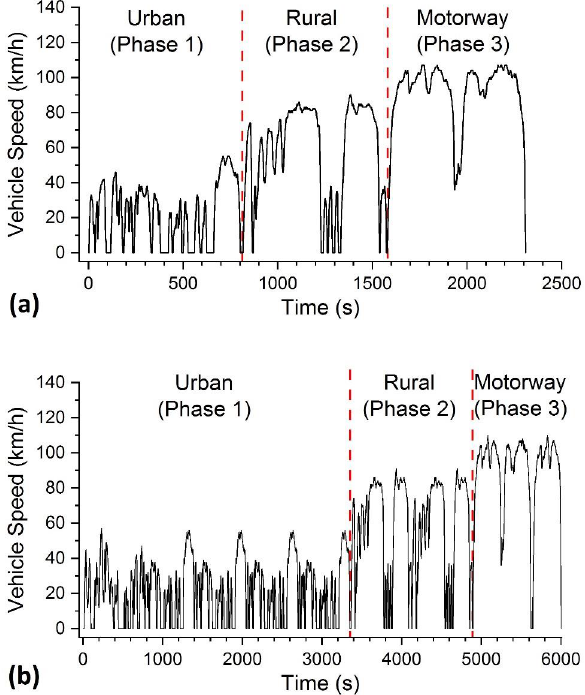
Figure 2. ( a ) Speed profiles of the shortened RDE-style chassis dynamometer drive cycle and ( b ) full RDE-style drive.